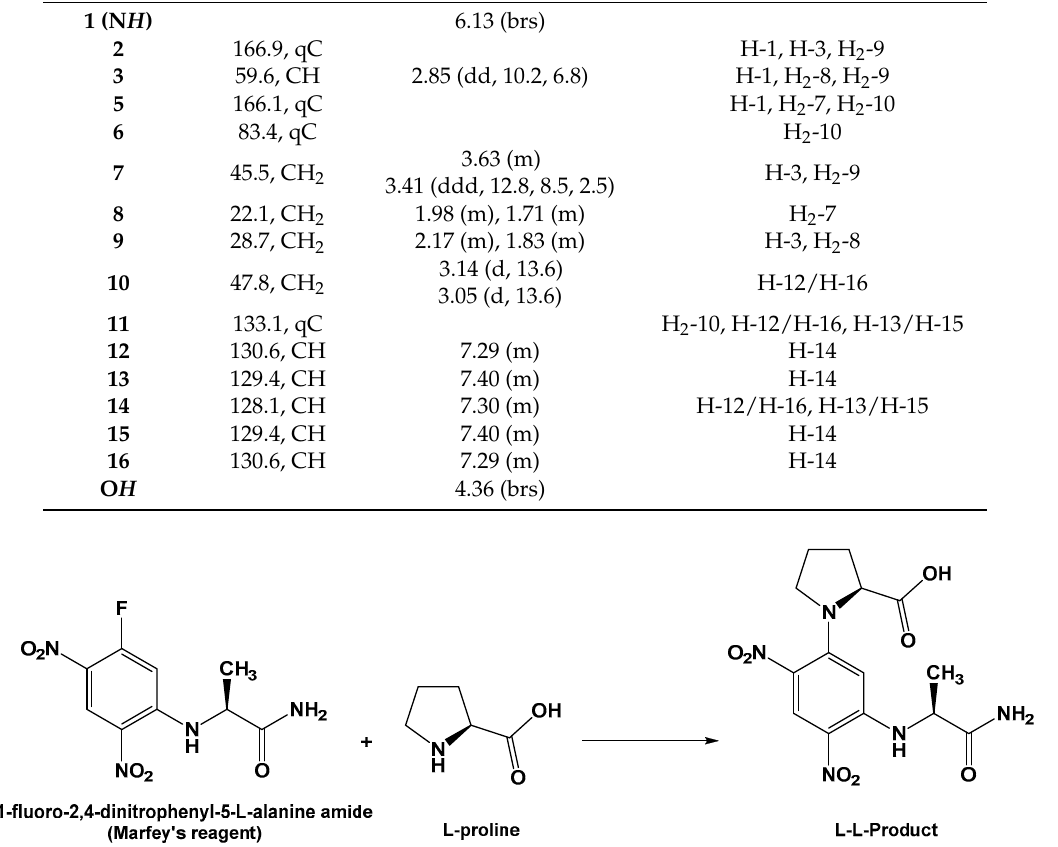
Table 2. NMR data of compound 2 (CDCl 3 , 600 and 150 MHz).